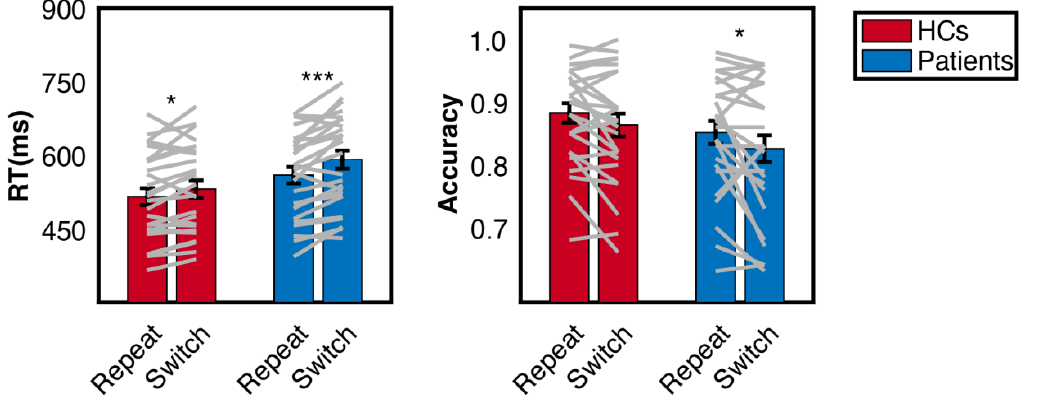
Figure 2. Reaction time and accuracy of patients and the HCs. Grey lines correspond to each participant. The errorbar represented the between-subject standard error. Asterisks indicate significance of simple effect analysis. * p < 0.05, *** p < 0.001.